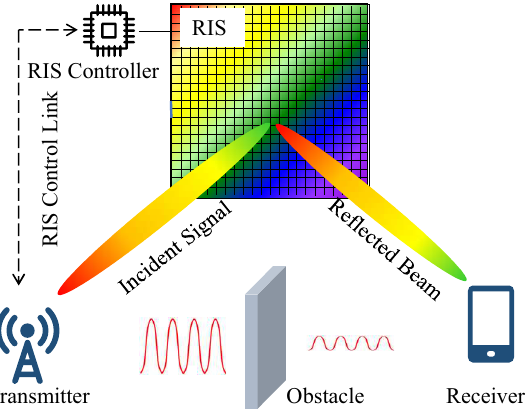
Figure 1. The RIS-assisted wireless communication